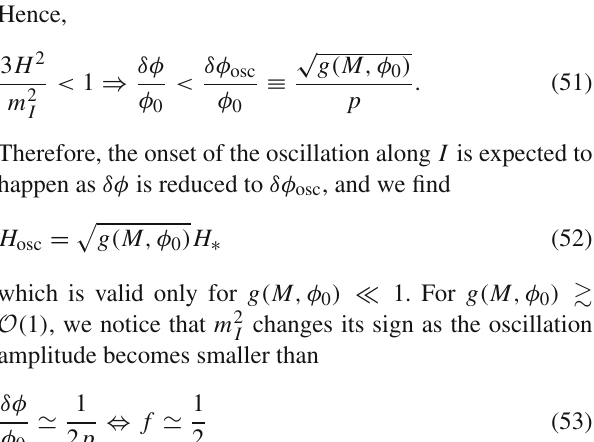
opaque green region is for g ( M ,φ 0 ) < | η obs | and excluded. Purple solid/dashed/dotted line is for H ∗ = H bnd ∗ / 10 13 GeV / 10 12 GeV. As inflationary observabels, n s = 0 . 9659 and P R = 2 . 1 × 10 − 9 were used [2]. 2- σ uncertainties in inflationary observables do not alter the figure significantly.Thetensor-to-scalarratiosonbluelinesare r ≈ 2 . 5 × 10 − 4 (dashed) and 2 × 10 − 5